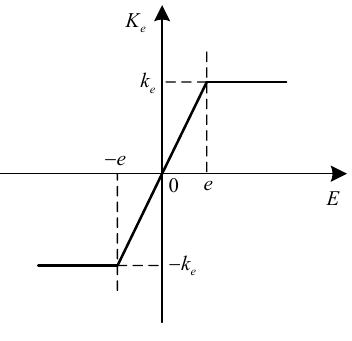
Figure 3. Sketch of the saturation